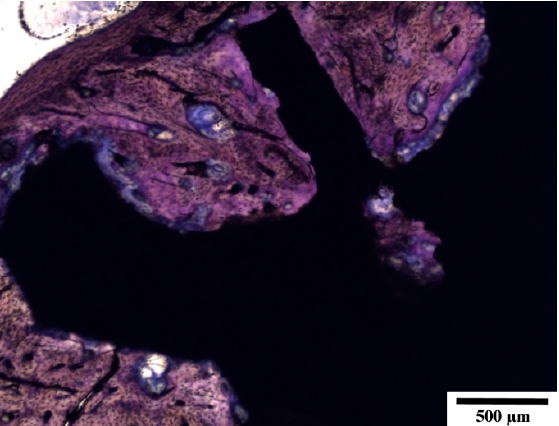
Figure 8. Very minimal disturbance of the contour sharpness showing a low level of resorption.